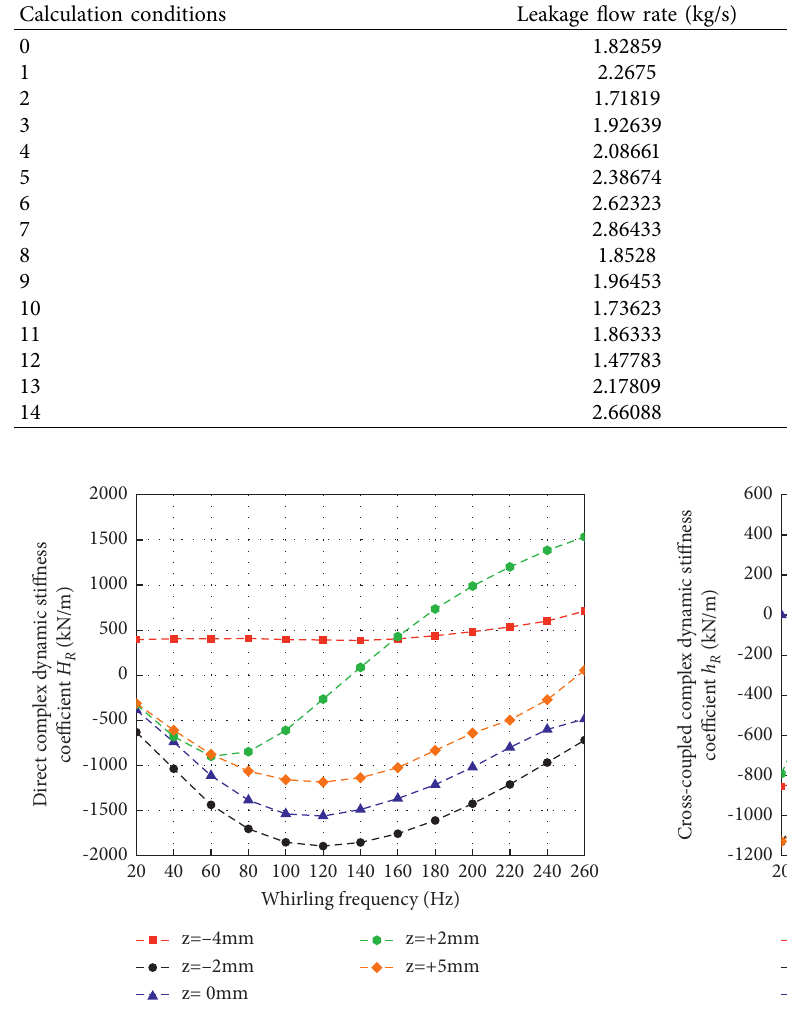
Figure 9: Cross-coupled complex dynamic stiffness coefficient vs. whirling